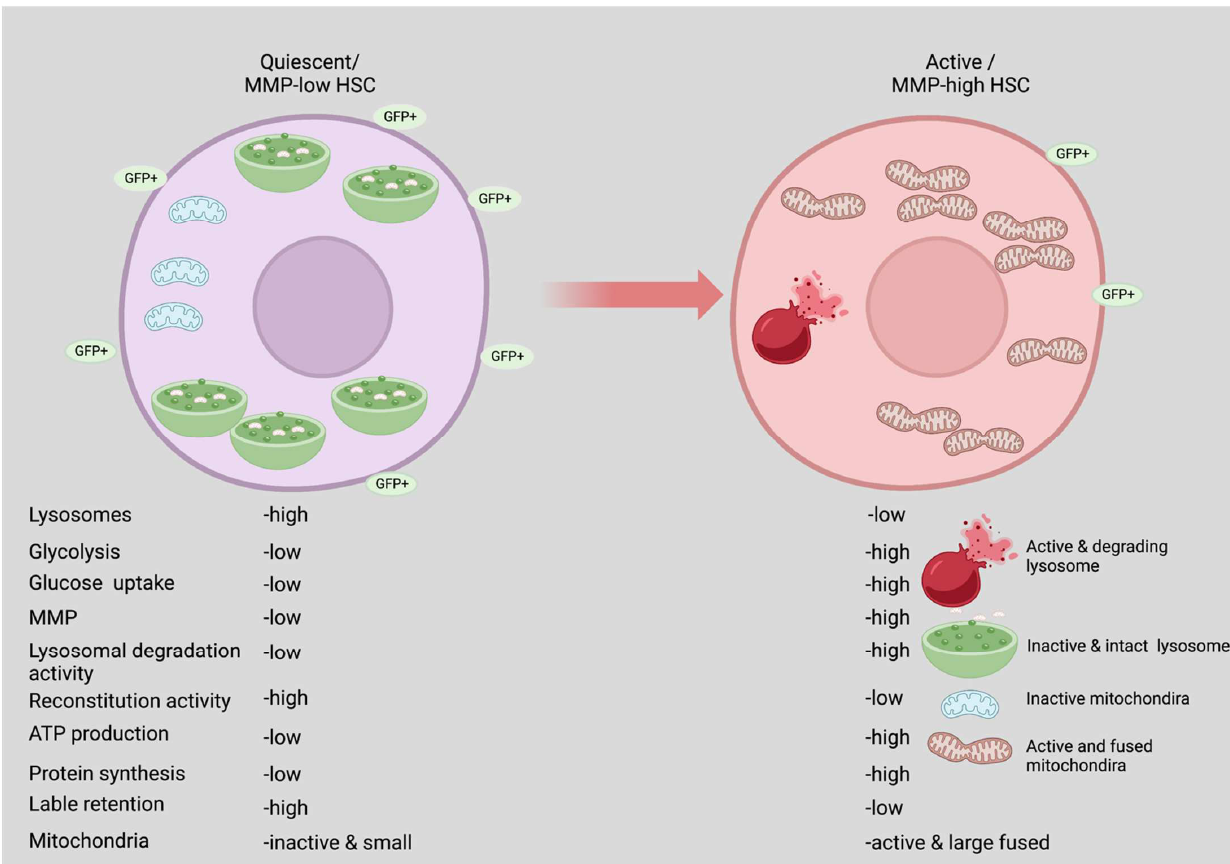
Figure 1. Quiescent vs. activated HSCs. Quiescent HSCs with low mitochondrial membrane poten- tial are very potent as compared to high mitochondrial membrane potential (MMP). Quiescent HSCs with low MMP have inactive lysosomes and more in number and size. Activated HSCs (MMP-high) have more lysosomal activity and degrading potential, glycolysis, and active and fused mitochon- dria. Created with BioRender.com 21 September 2022.